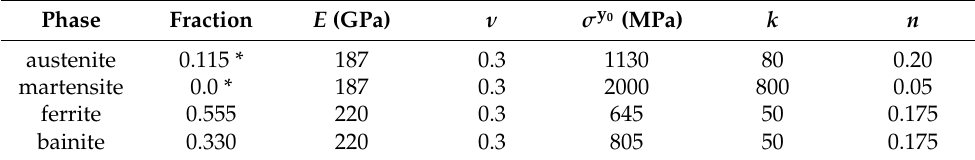
Table 1. Mechanical properties of each phase used in the simulation of TRIP steel. Phase Fraction E (GPa) austenite martensite 0.0